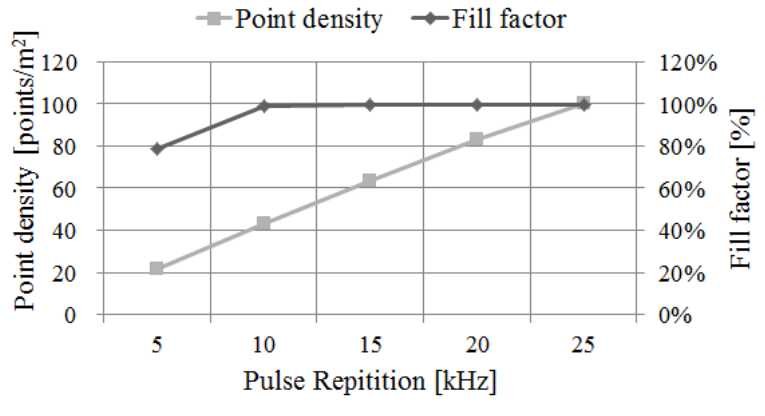
Figure 25. Variations of point density (inliers) and fill factor according to the changes of pulse repetition